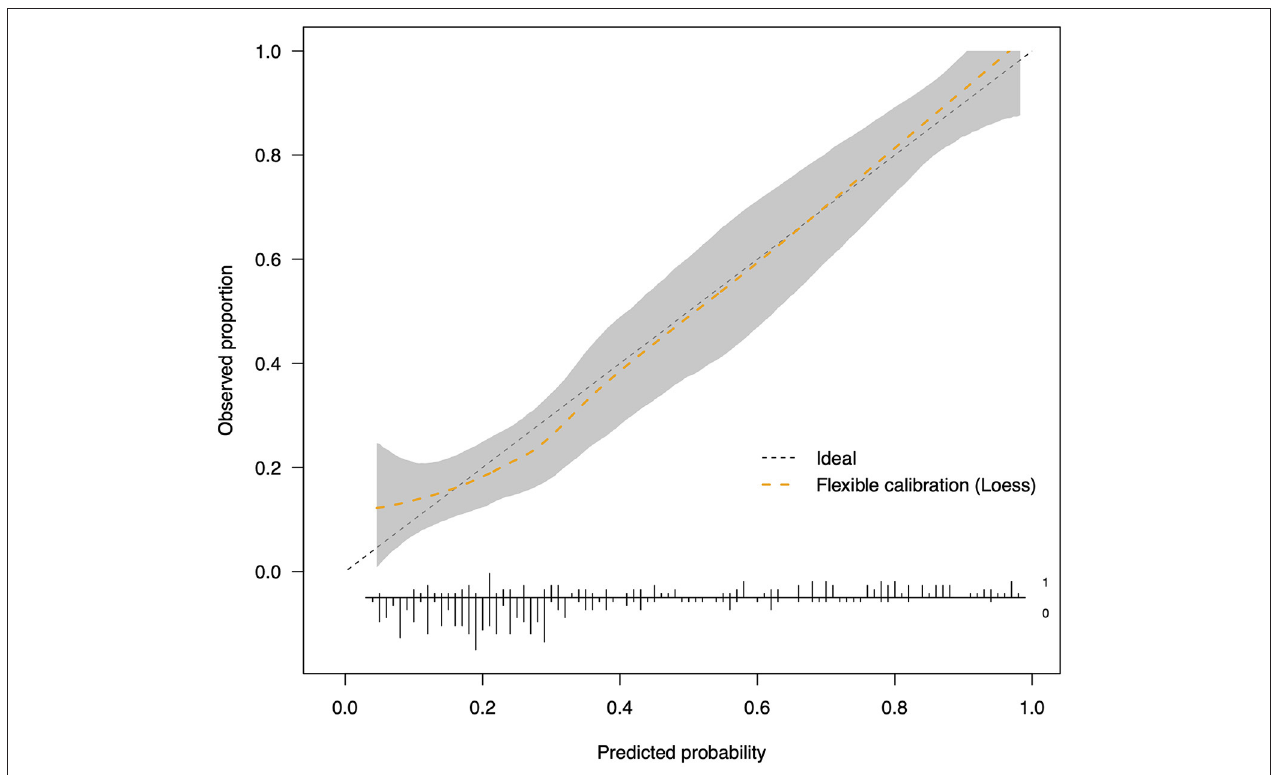
FIGURE 2 | Calibration plot after internal validation by bootstrapping ( n = 1,000). The dotted straight reference line corresponds to prefect calibration with a calibration slope of 1. When the calibration curve is above the reference line, the probabilities of freezing development are underestimated; when it is beneath the reference line, the probabilities are overestimated. The range shaded in gray represents 95% CIs of the LOESS curve. The distribution of predicted risk is shown at the bottom of the